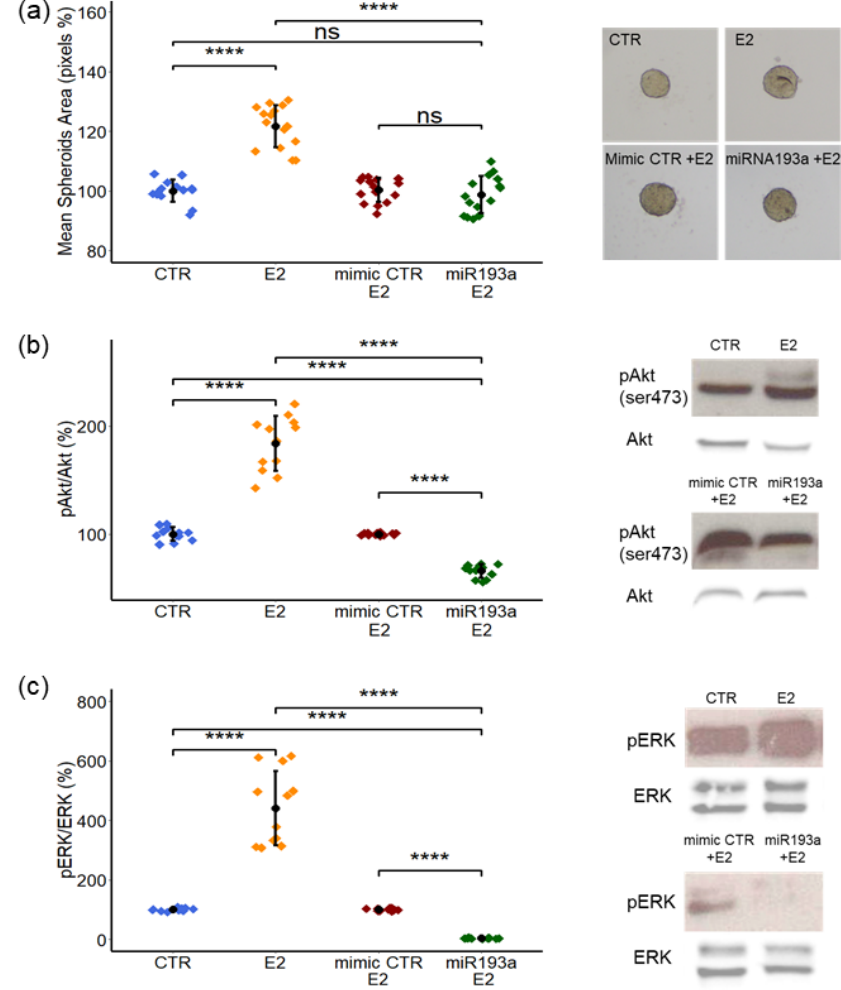
Figure 6. E2-induced spheroid (LEC + MCF-7) growth and signal transduction (AKT, ER1/2 phosphorylation) is abrogated by miR193a. ( a ) Spheroid growth was assessed by pixel analysis of images to calculate the total area of LEC + MCF-7 spheroids treated with the vehicle or 10 nM E2. LEC + MCF-7 spheroids developed using cells transfected with 25 nM of mimic CTR or miRNA193a were exposed to the vehicle or 10 nM E2. Pixel analysis was performed using ImageJ to calculate spheroid area. Representative Western blots and graphs depict AKT ( b ) and ERK ( c ) phosphorylation in lysates from spheroids (mimic control or miR193a) treated with the vehicle (DMSO) or 10 nM of E2/DMSO. The band intensity was quantified using ImageJ software. Phosphorylated protein intensity was normalized to the total protein (ERK and AKT). Data represent the mean ± SD and experiments performed at least three times in triplicates. p < 0.00001 **** compared to the respective control. Since E2 induces LEC growth by downregulating miR193a-3p, we investigated whether it is also involved in modulating the stimulatory actions of E2 on AKT and ERK phosphorylation in spheroids. To achieve our goal, LEC + MCF-7 spheroids transfected with the mimic control or miR193a-3p were cultured for 4 days in an E2 treatment medium. Western blot analysis showed that the stimulatory effects of E2 on AKT and ERK phosphorylation are lost in lysates from spheroids transfected with miR193a-3p (Figure